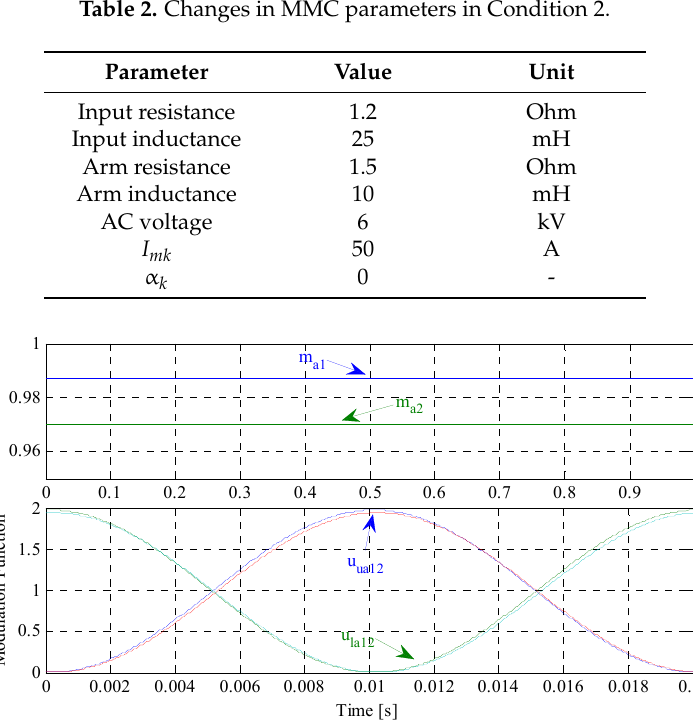
Figure 4. The proposed modulation index and function based on parameters variations given in Table 2.